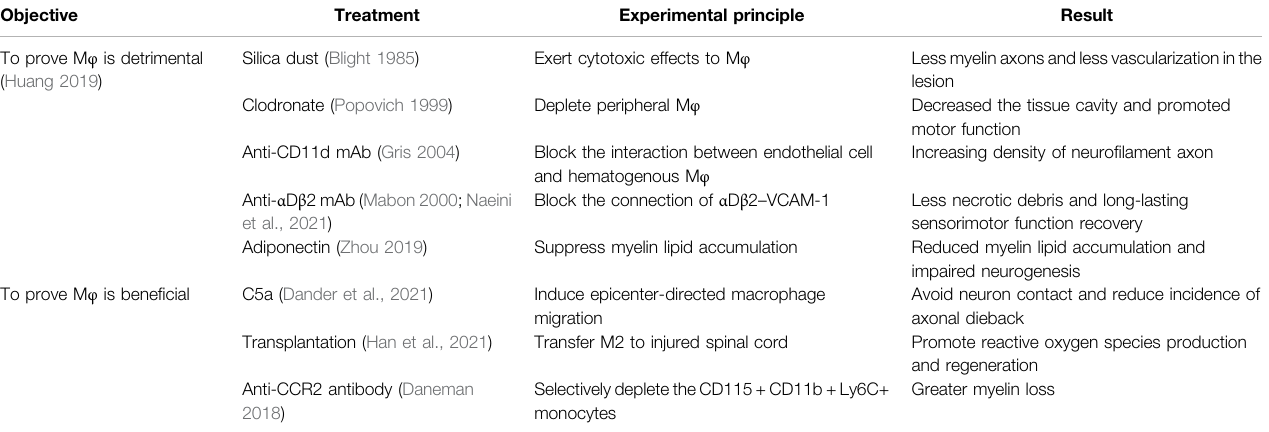
TABLE 2 | Different treatments towards hematogenous